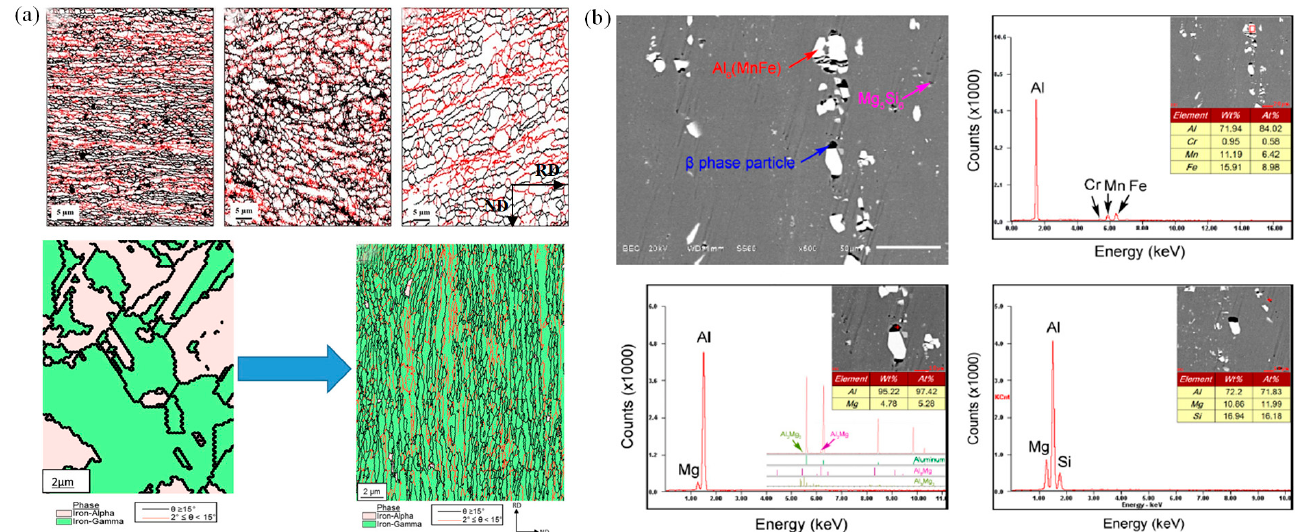
Figure 4. The superplastic deformation instability behavior of an aluminum alloy: ( a ) grain boundary slip leads to superplastic deformation instability [75,76]; ( b ) fine precipitates dispersed during the superplastic deformation process [77].